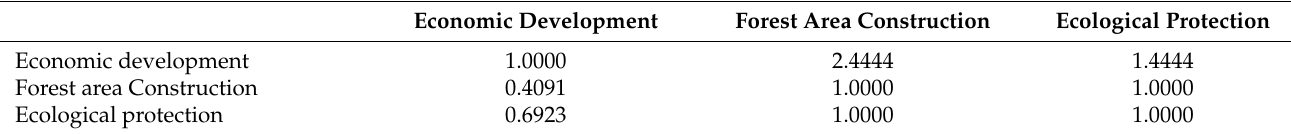
Table A2. B1–C: Judgement matrix of the poverty alleviation achievements.